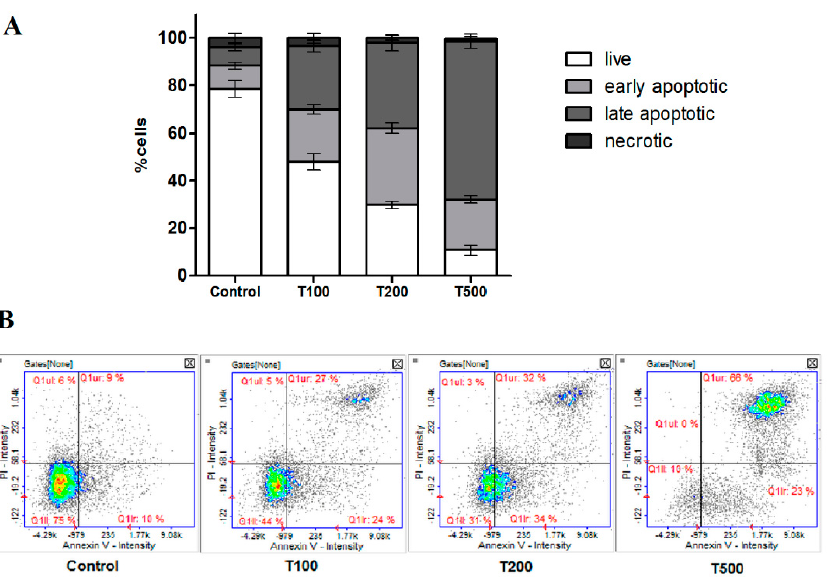
Figure 6. ( A ) Detection of cell apoptosis/necrosis in RPMI 8226 cells with annexin V-FITC and propidium iodide staining using image cytometry. The MM cells were treated with teriflunomide (T) (100–500 µM) or DMSO as vehicle in control cultures for 24 h. Values were presented as mean ± SD derived from three independent experiments. ( B ) The results show one representative experiment of three independently performed. Q1II-live, Q1lr- early apoptotic, Q1ur- late apoptotic, and Q1uI- necrotic cells.